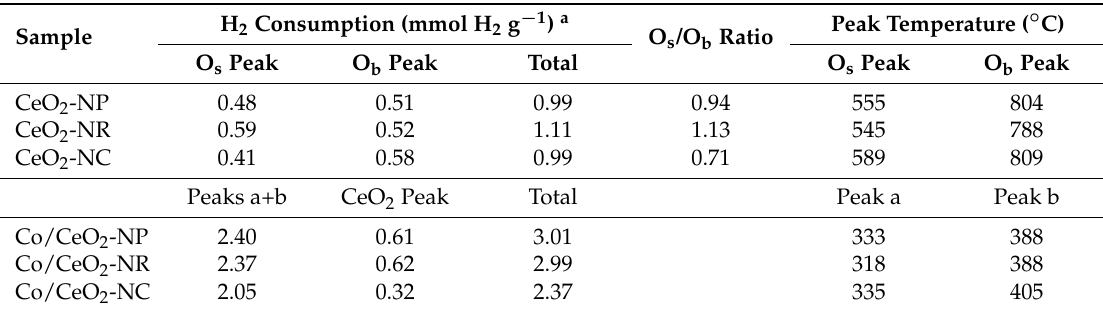
Table 2. The redox properties of the bare CeO 2 and Co/CeO 2